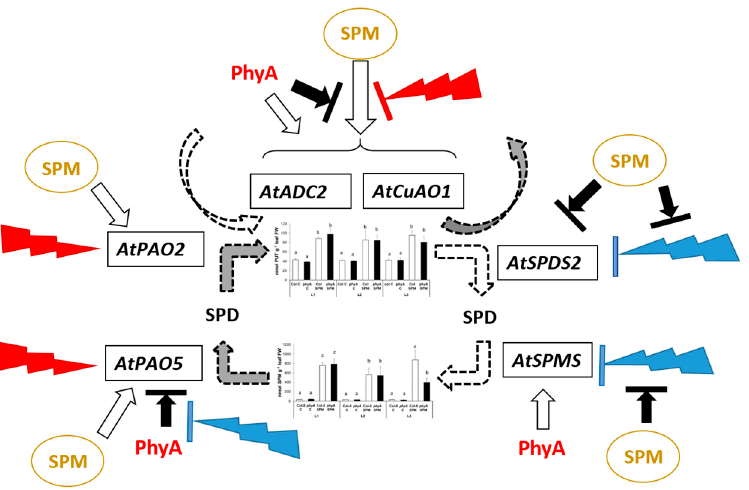
Figure 6. Schematic mode of action of spermine (SPM) treatment on polyamine metabolism under different light spectral compositions and influence of PhyA on it. PUT: putrescine, SPD: spermidine, SPM: spermine content, AtADC2 : arginine decarboxylase 2, AtSPDS2 : spermidine synthase 2, At- SPMS : spermine synthase, AtCuAO3 : cooper amine-oxidase 3, AtPAO2 and AtPAO5 : polyamine oxidase 2 and 5. Blue lightning arrows indicate blue light treatment, red lightning arrows indicate far-red light treatment, SPM indicates spermine treatment, and PhyA means the presence of the wild type of phytochrome A. Different letters indicate statistically significant differences at p < 0.05 level, using Duncan’s post hoc